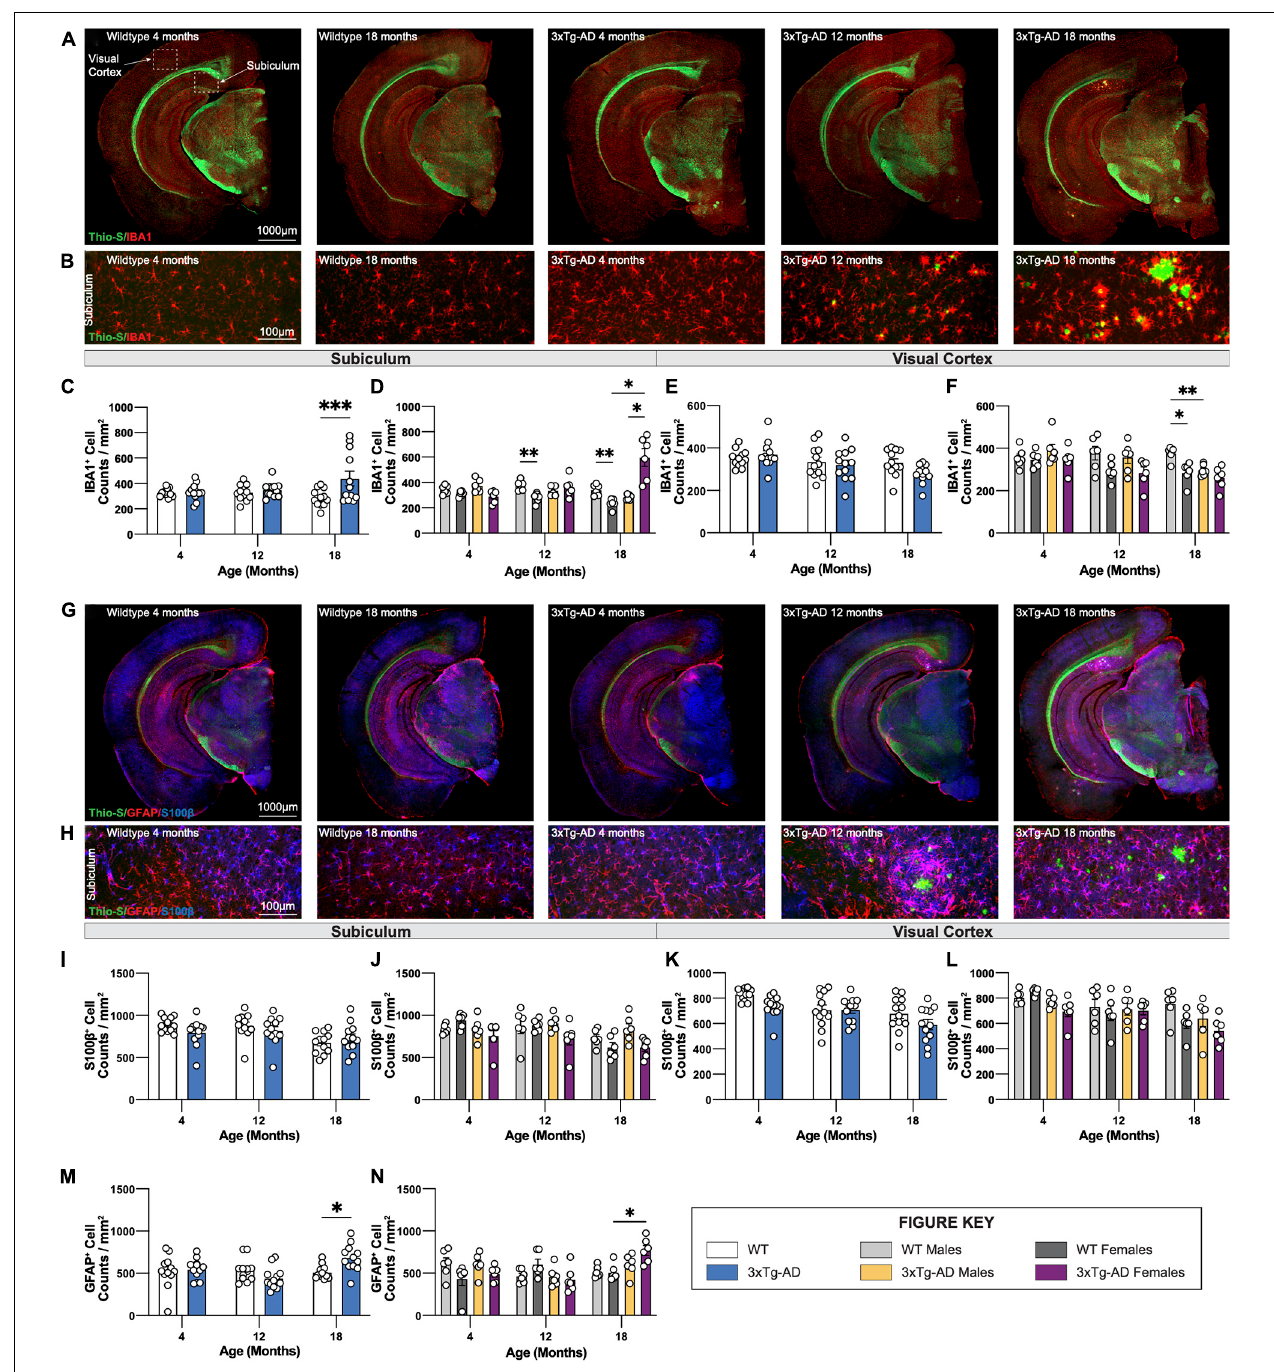
FIGURE 7 | Immunostaining of microglia and astrocytes. Brains of mice at each timepoint were coronally sectioned and immunostained for IBA1, GFAP, and S100 β to identify changes in microglia or astrocytes. (A) Representative stitched images of brain hemispheres of WT (4-, 18-month) and 3xTg-AD mice (4-, 12-, 18-month) stained with Thio-S/IBA1. (B) Representative images of IBA1 + cells surrounding Thio-S + in subiculum hippocampal regions of WT and 3xTg-AD mice at indicated timepoints. (C–F) Age-related changes microglial density in both WT and 3xTg-AD, and differences between genotypes in subiculum hippocampal and cortical regions. (G) Representative images of brain hemispheres of WT (4-, 18-month) and 3xTg-AD mice (4-, 12-, 18-month) stained with Thio-S/GFAP/S100 β . (H) Representative images of GFAP + and S100 β + cells surrounding Thio-S + plaques in subiculum hippocampal regions of WT and 3xTg-AD mice at indicated timepoints. (I–N) Astrocyte density as assessed via S100 β (I–L) and GFAP (M,N) staining in the subiculum hippocampal and cortical regions. Age-related changes in both WT and 3xTg-AD astrocytic density, and differences between genotypes in both subiculum hippocampal and cortical regions. n = 5–6 mice per genotype/age/sex. Data are represented as mean ± SEM. ∗ p ≤ 0.05, ∗∗ p ≤ 0.01, ∗∗∗ p ≤ 0.001.